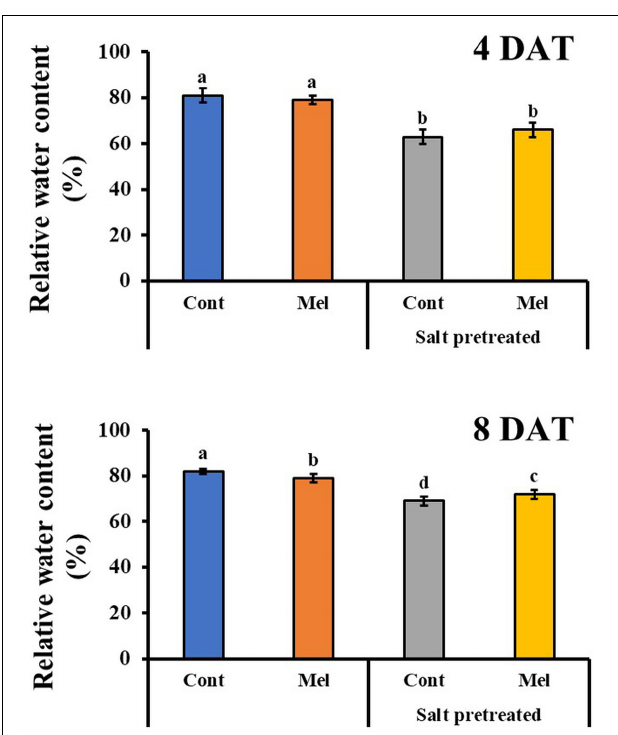
FIGURE 6 | Effect of melatonin with/without salt stress on relative water content in green mustard seedlings. The results were calculated from data for 4 (4DAT) and 8 (8DAT) days. Treatment: control + water, control + 1 µ M melatonin, 150 mM salt pre-treatment + water, 150 mM salt pre-treatment + 1 µ M melatonin. Values show the means ± SE ( n = 3). Letters represent significant differences at p < 0.05 in accordance with Duncan’s multiple range